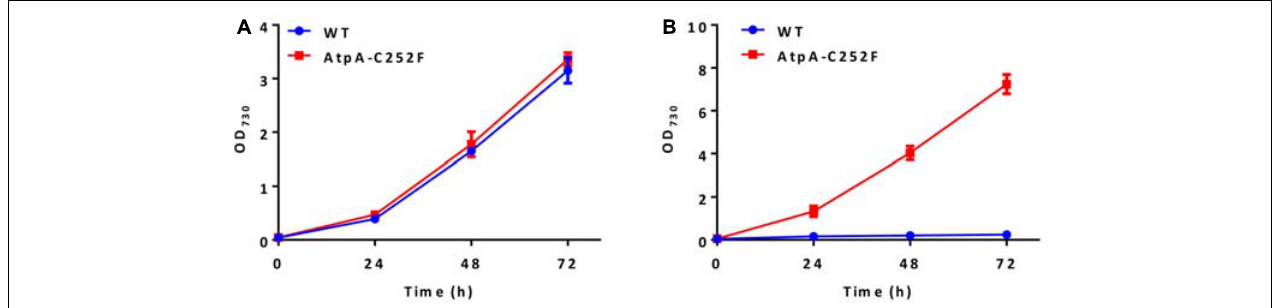
FIGURE 2 | Effect of the AtpA-C252F mutation on cellular growth and tolerances of PCC 7942. Growth of the PCC 7942 strain with or without the AtpA-C252F mutation in liquid BG11 medium at 30 ◦ C with 50 µ mol photons/m 2 /s illumination (A) and at 44 ◦ C with 400 µ mol photons/m 2 /s illumination (B) . Error bars indicate standard deviations ( n = 3).